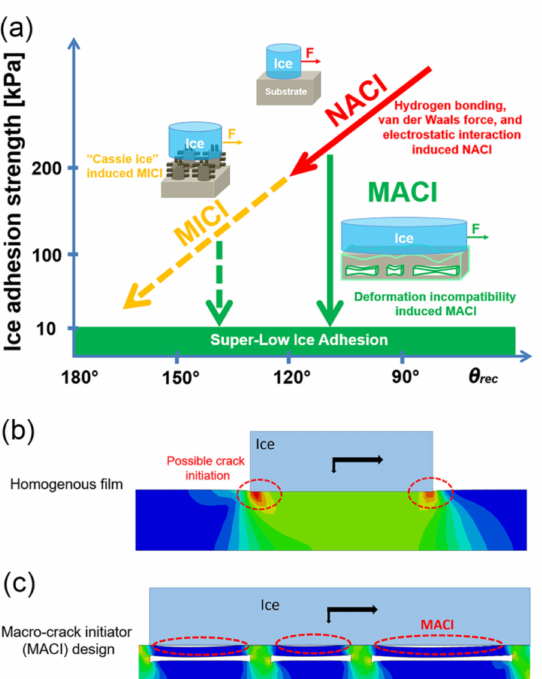
Figure 12. ( a ) Multiscale crack-initiator mechanisms at an ice–substrate interface. The red line represents nanoscale-initiator (NACI) mechanism. The yellow line denotes microscale-initiator (MICI) mechanism. The green lines show the proposed macroscale-initiator (MACI) mechanism that can function on any surfaces with deformation incompatibility, and bring ice adhesion strength down to the super-low regime. 2D plane strain finite element analyses using ABAQUS to illustrate the MACI mechanism, ( b ) ice adhesion test on a homogenous film and ( c ) ice adhesion test on the proposed film with substructures. The black arrows resemble the applied forces. ( a – d ) reproduced with permission from [13], Copyright 2017 the Royal Society of